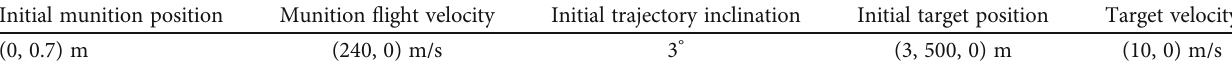
Table 1: Initial